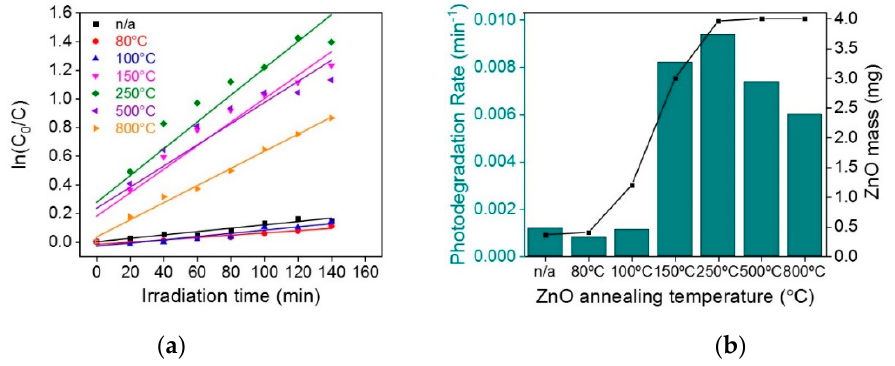
Figure 10. ( a ) First order equation of the kinetic reaction of different sizes of ZnO NP annealed at different temperatures plotted by ln(C 0 /C) versus irradiation time and ( b ) comparative photodegradation rates of MB dye with different sizes of ZnO NP annealed at various temperatures.